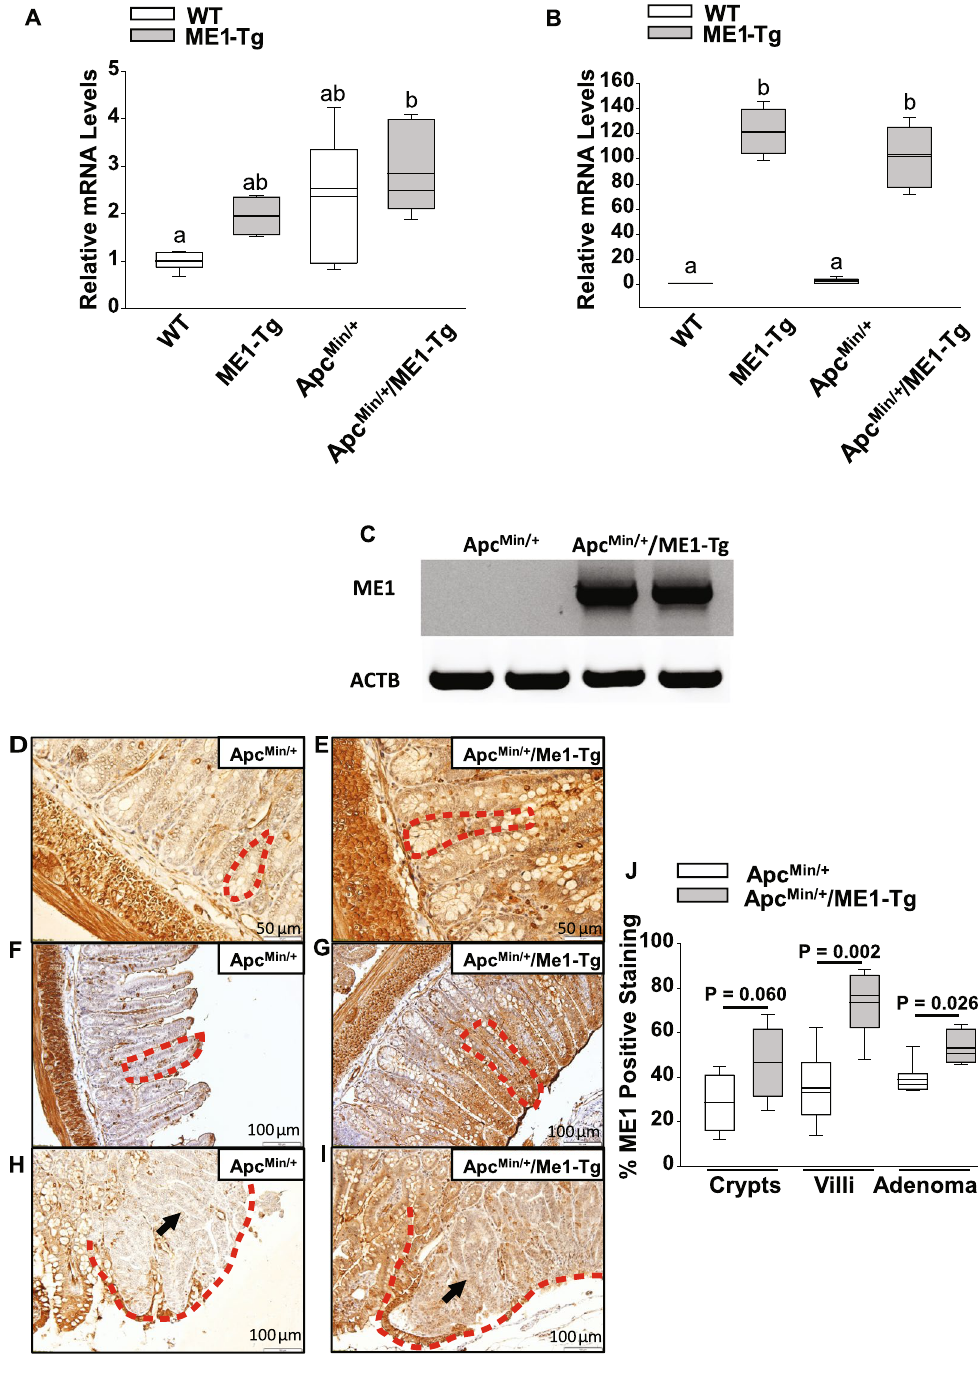
Figure 1. ME1 expression in Apc Min/ + /ME1-Tg mouse intestines. ( A ) qRT-PCR of mouse Me1 RNA in the jejunums of WT, ME1-Tg, Apc Min/ + and Apc Min/ + /ME1-Tg male mice (n = 4–6/group). ( B ) qRT-PCR of total Me1 (endogenous + transgene-derived) mRNA in the jejunums of WT, ME1-Tg, Apc Min/ + and Apc Min/ + / ME1-Tg male mice (n = 4–6/group). One-Way ANOVA was used to examine for differences between groups (All Pairwise Multiple Comparison Procedures; Holm-Sidak method). Different lowercase letters (a, b) designate groups that differ (P < 0.05); however, bars sharing the same letter are not different. ( C ) Conventional RT-PCR of transgene-expressed Me1 mRNA in Apc Min/ + and Apc Min/ + /ME1-Tg male jejunums (n = 2/group). Gel lanes were cropped for purposes of space. The corresponding full-length gels are presented in Supplementary Fig. 7. ( D to I ) Representative ME1 IHC of Swiss-rolled ilea from Apc Min/ + and Apc Min/ + / ME1-Tg male mice. ( D,E ) crypts (scale bar = 50 μ m); ( F, G ) villi (scale bar = 100 μ m); ( H,I ) adenomas (scale bar = 100 μ m). Red dotted lines delineate crypts ( D,E ), villi ( F,G ) and adenomas ( H,I ). Black arrows point to centers of adenomas ( H,I ). ( J ) Percentage ME1-positive staining of crypts, villi (epithelium and lamina propria ) and adenomas in ilea of male mice. Quantification was via Aperio Imagescope. Boxes demarcate the